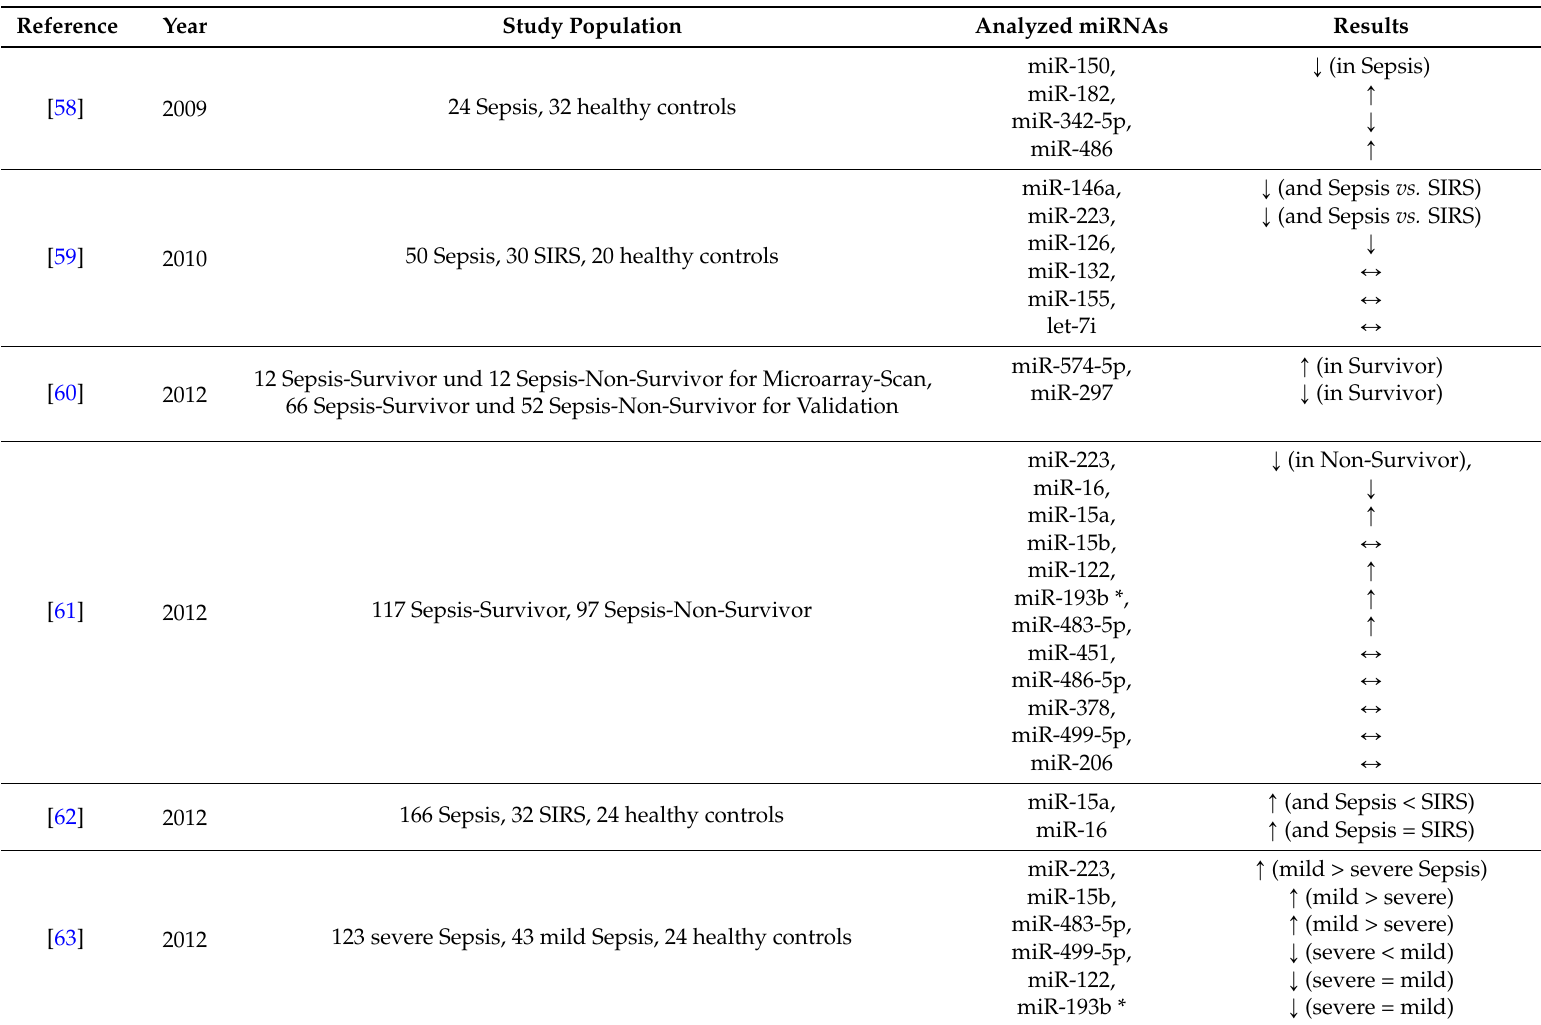
Table 1. Overview of studies that examined circulating miRNAs as biomarkers in critically ill patients with or without